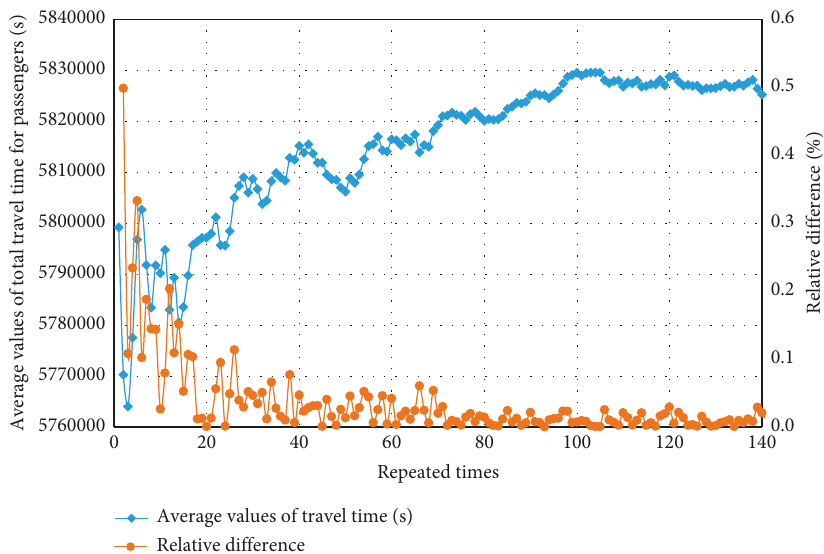
Figure 4: Convergent tendency with increasing simulation times.